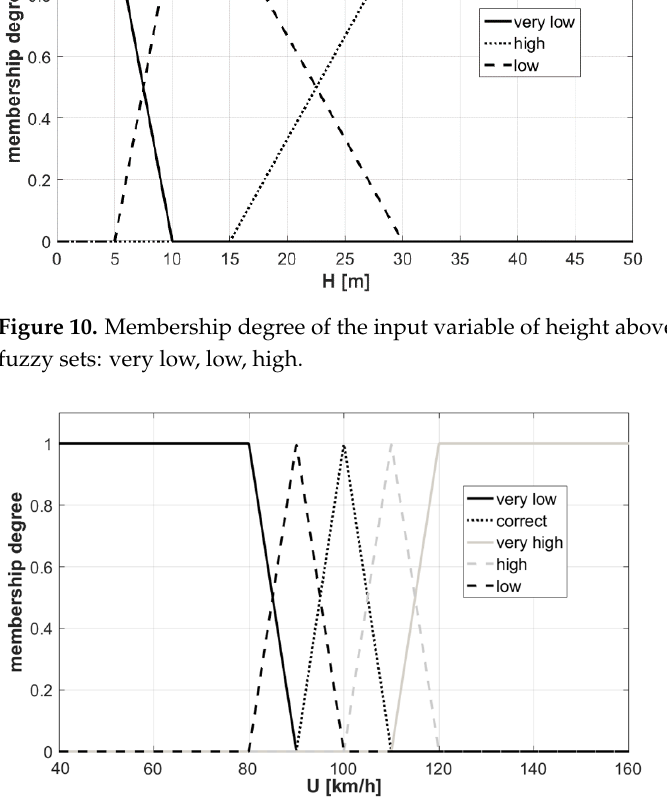
Figure 11. Membership degree of the input variable of airspeed U associated with fuzzy sets: very low, low, correct, high, and very high.